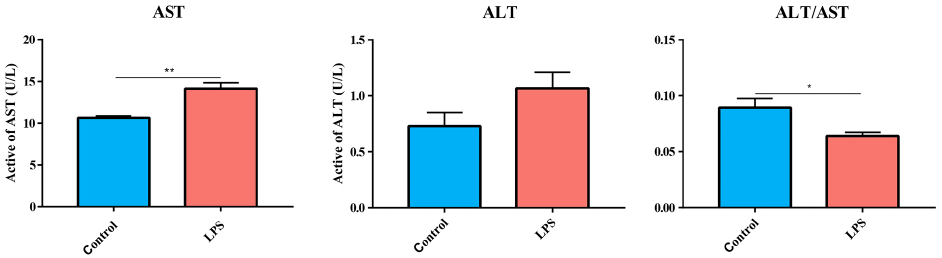
Figure 2. Effect of LPS-induced ALT and AST in the livers of goslings. * indicated p < 0.05, ** indi- cated p < 0.01.